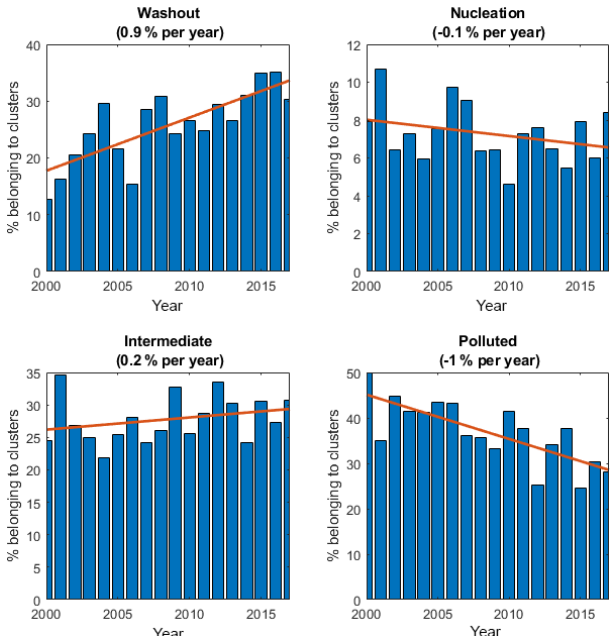
Figure 12. Inter-annual trends of major cluster groups washout (cluster 1), nucleation (clusters 2 through 6), intermediate (clusters 7 to 9) and polluted (clusters 10–12). Fitted linear trend and annual decrease are indicated in